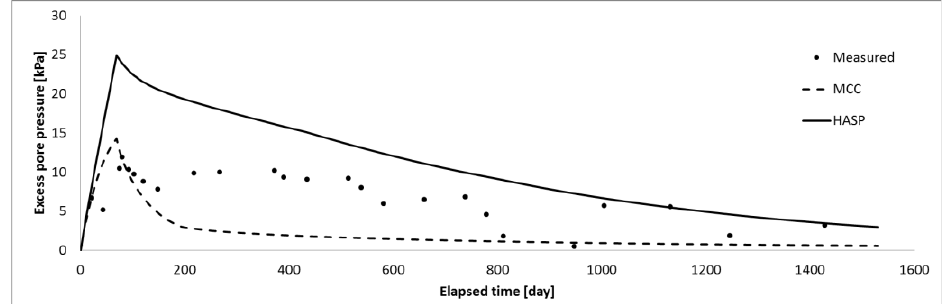
Figure 17. Comparison of excess pore pressure-time curves for Embankment B — Point PC2-1 (3.0 m below the surface).